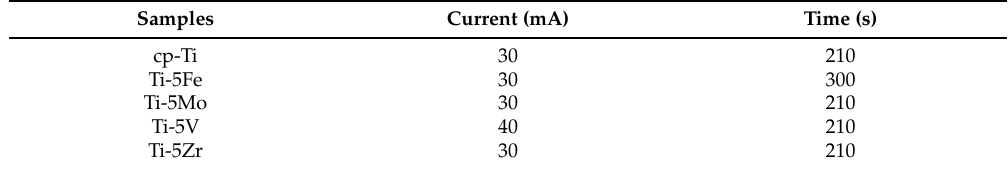
Table 1. The applied current and time for anodization of commercially pure (cp)-Ti and Ti alloys.